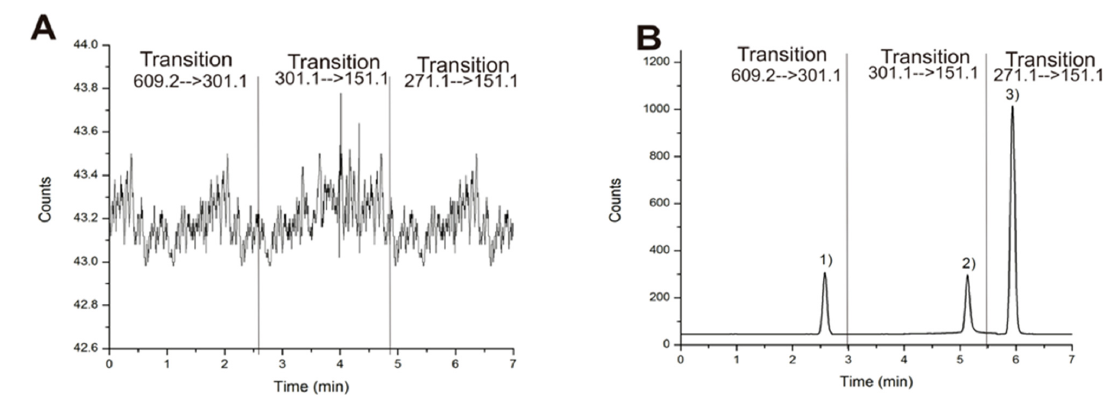
Figure 1. ( A ) Blank plasma matrix chromatogram and ( B ) spiked sample chromatogram at 10 ng/mL b calculated by multiple reaction monitoring with each transition. (1) hesperidin, (2) quercetin, and (3) naringenin.